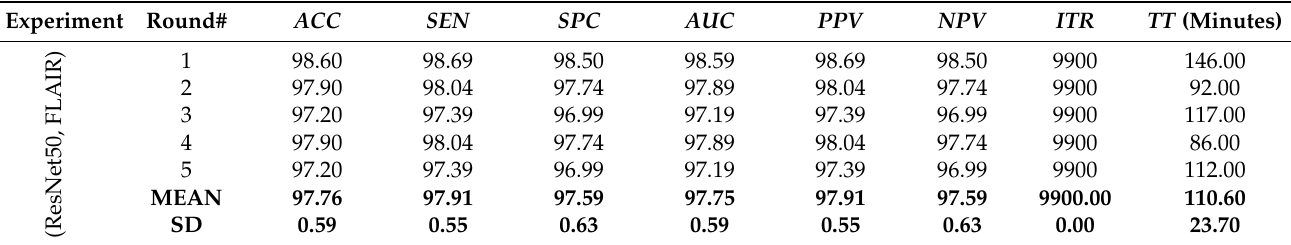
Table A19. Test results of five-folds of the experiment (ResNet50,